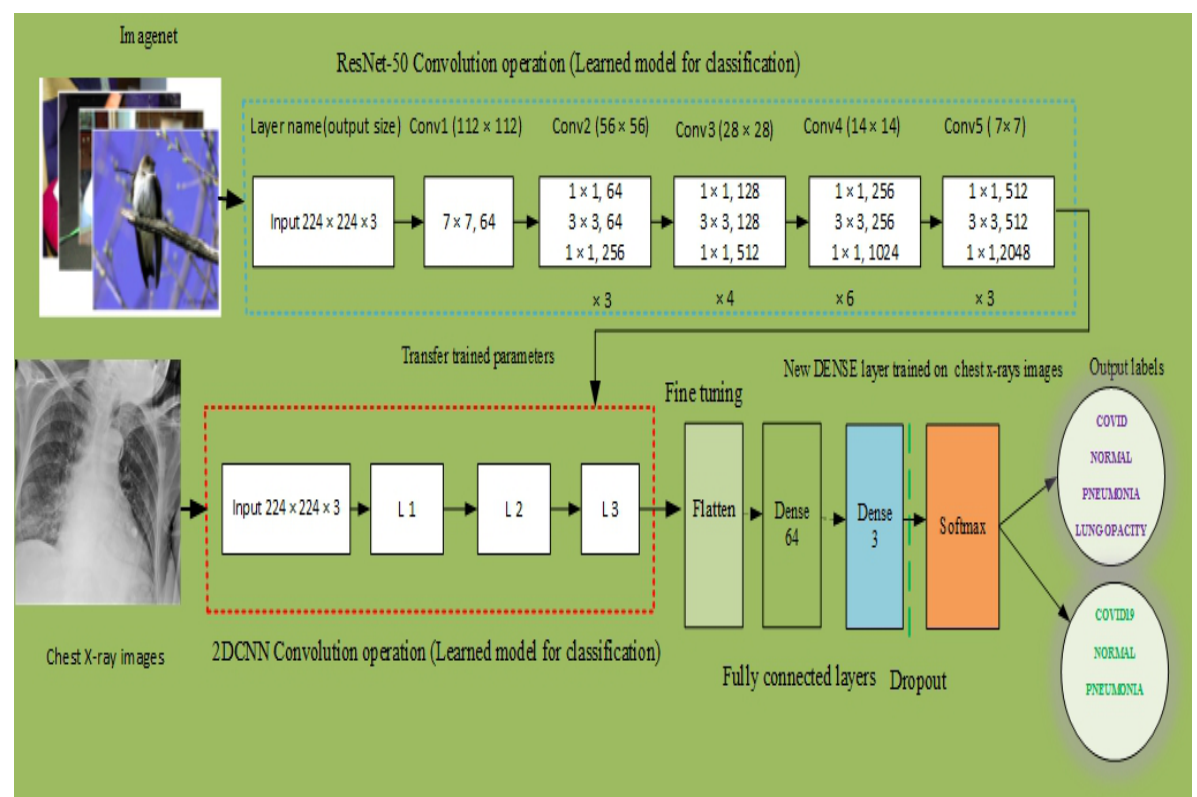
Figure 2. Proposed R2DCNNMC model for COVID-19 diagnosis.